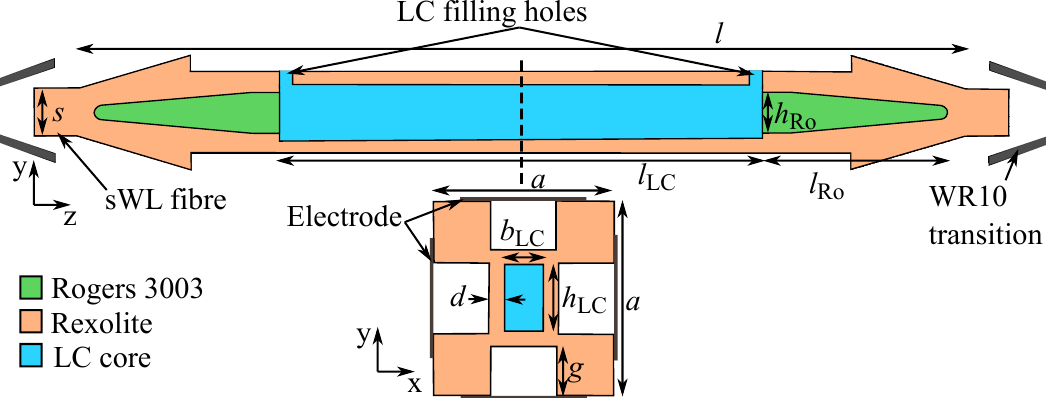
Figure 10. Schematic of the SIF LC phase shifter, presented in [22]. All dimensions in mm: l = 35, l LC = 19, l Ro = 6.28, h Ro = 1.6, h LC = 2.2, b LC = 1.4, a = 6.5, d = 0.55, g = 2, s =